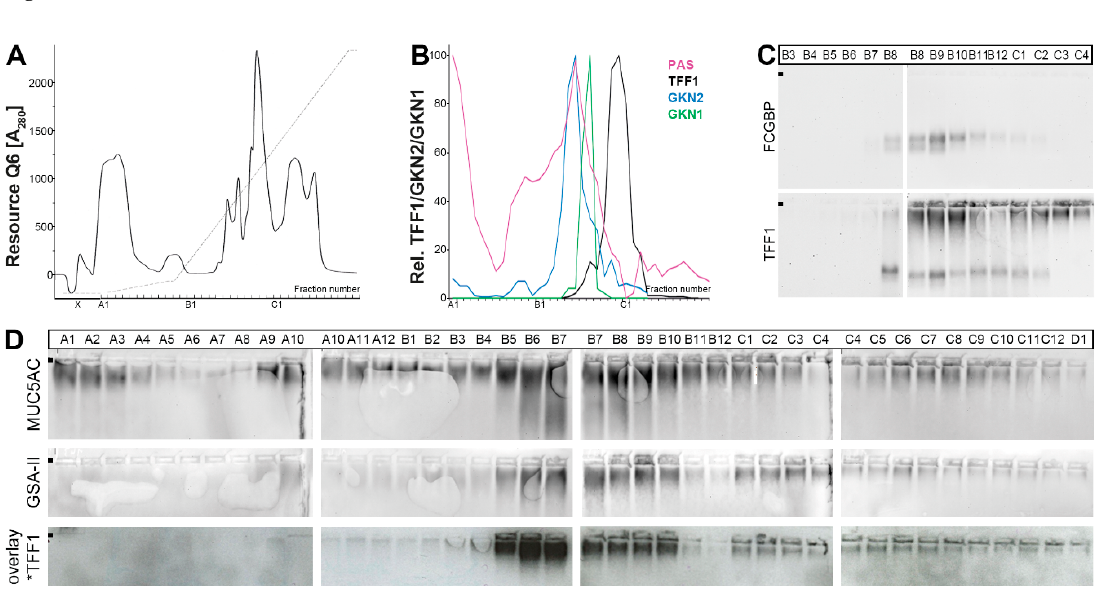
Figure 5. Analysis of human gastric corpus E1-extract (M C -577) and binding study with 125 I-labeled synthetic human TFF1 homodimer. ( A ) Elution profile after anion-exchange chromatography on a Resource Q6 column, as determined by absorbance at 280 nm. Elution was with a salt gradient (dashed line). ( B ) Distribution of the relative TFF1 (black), GKN2 (blue), and GKN1 (green) immunoreactivities respectively, as determined by Western blot analysis under reducing conditions and semi-quantitative analysis of the typical monomeric band intensities. The mucin content (PAS reaction) is shown in pink. ( C ) 1% AgGE and subsequent Western blot analysis of the fractions B3-C4. The start is marked with a dot on the left. Shown are the reactivities for FCGBP and TFF1, respectively. ( D ) 1% AgGE and subsequent Western blot analysis of the fractions A1-D1. Shown are the reactivities for MUC5AC, MUC6 (lectin GSA-II), and the hybridization signals (autoradiography) obtained after incubating the blot with 125 I-labeled synthetic human TFF1 homodimer (overlay assay),